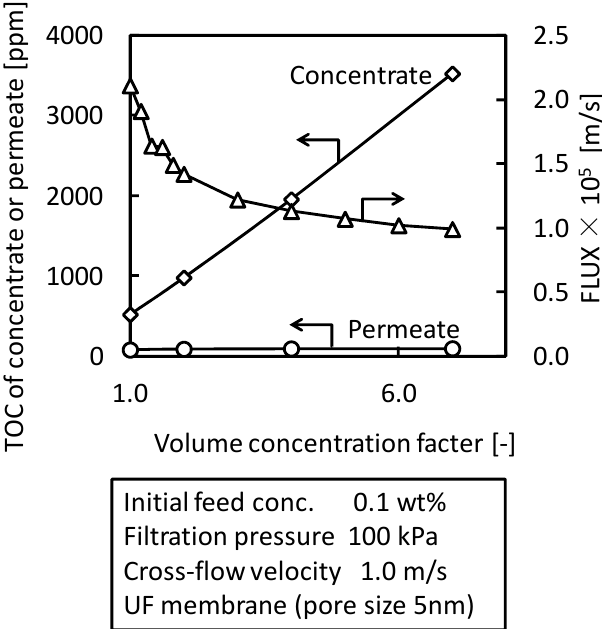
Figure 8. Concentration properties of O/W emulsion in batch cross-flow concentration filtration with UF membrane (pore size 5 nm).